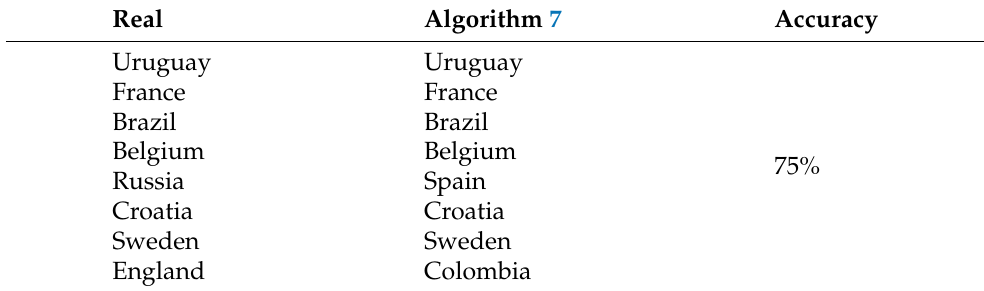
Table 15. Quarterfinalists.